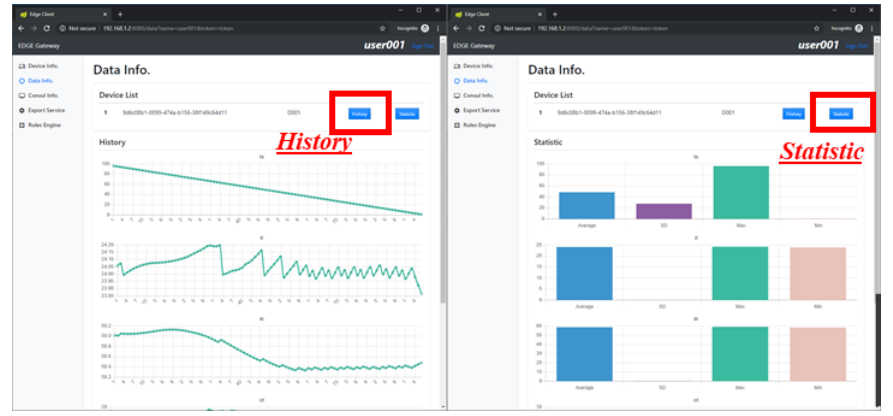
Figure 13. Data visualization on edge client.